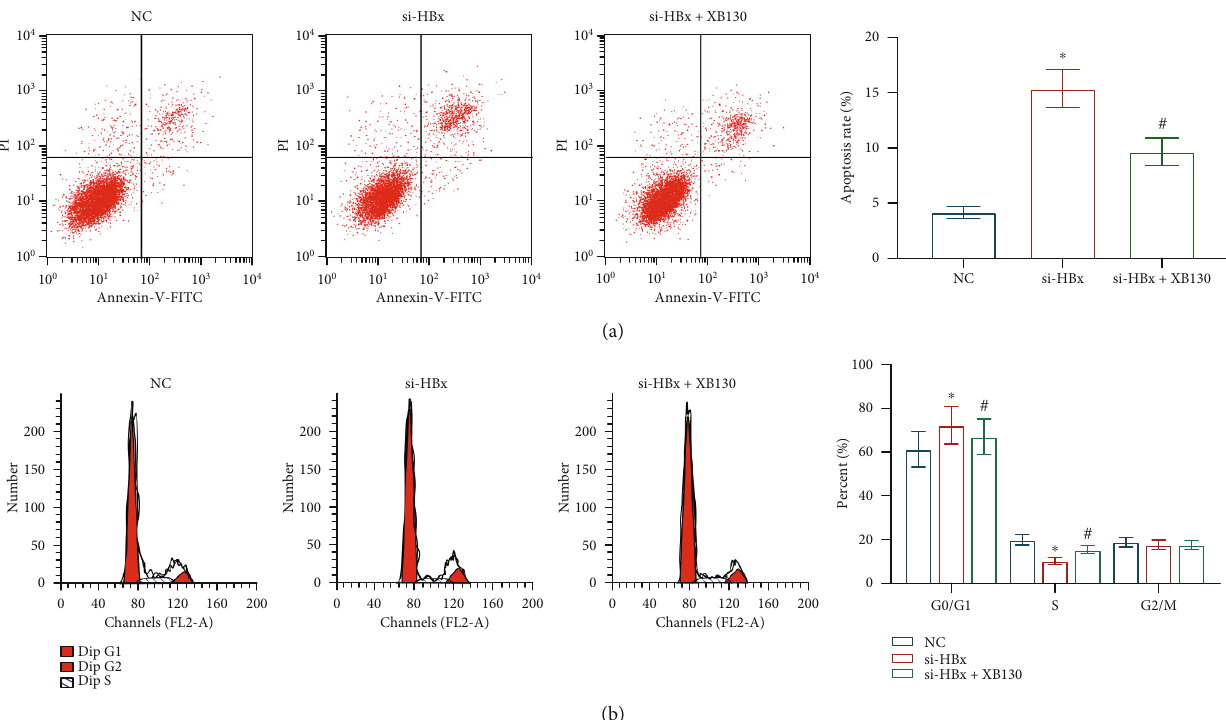
Figure 6: HBx suppresses apoptosis of HepG2 cells by increasing XB130 expression. (a) Cell apoptosis examined using fl ow cytometry. (b) Cell cycle determined using fl ow cytometry. ∗ # p < 0 : 05